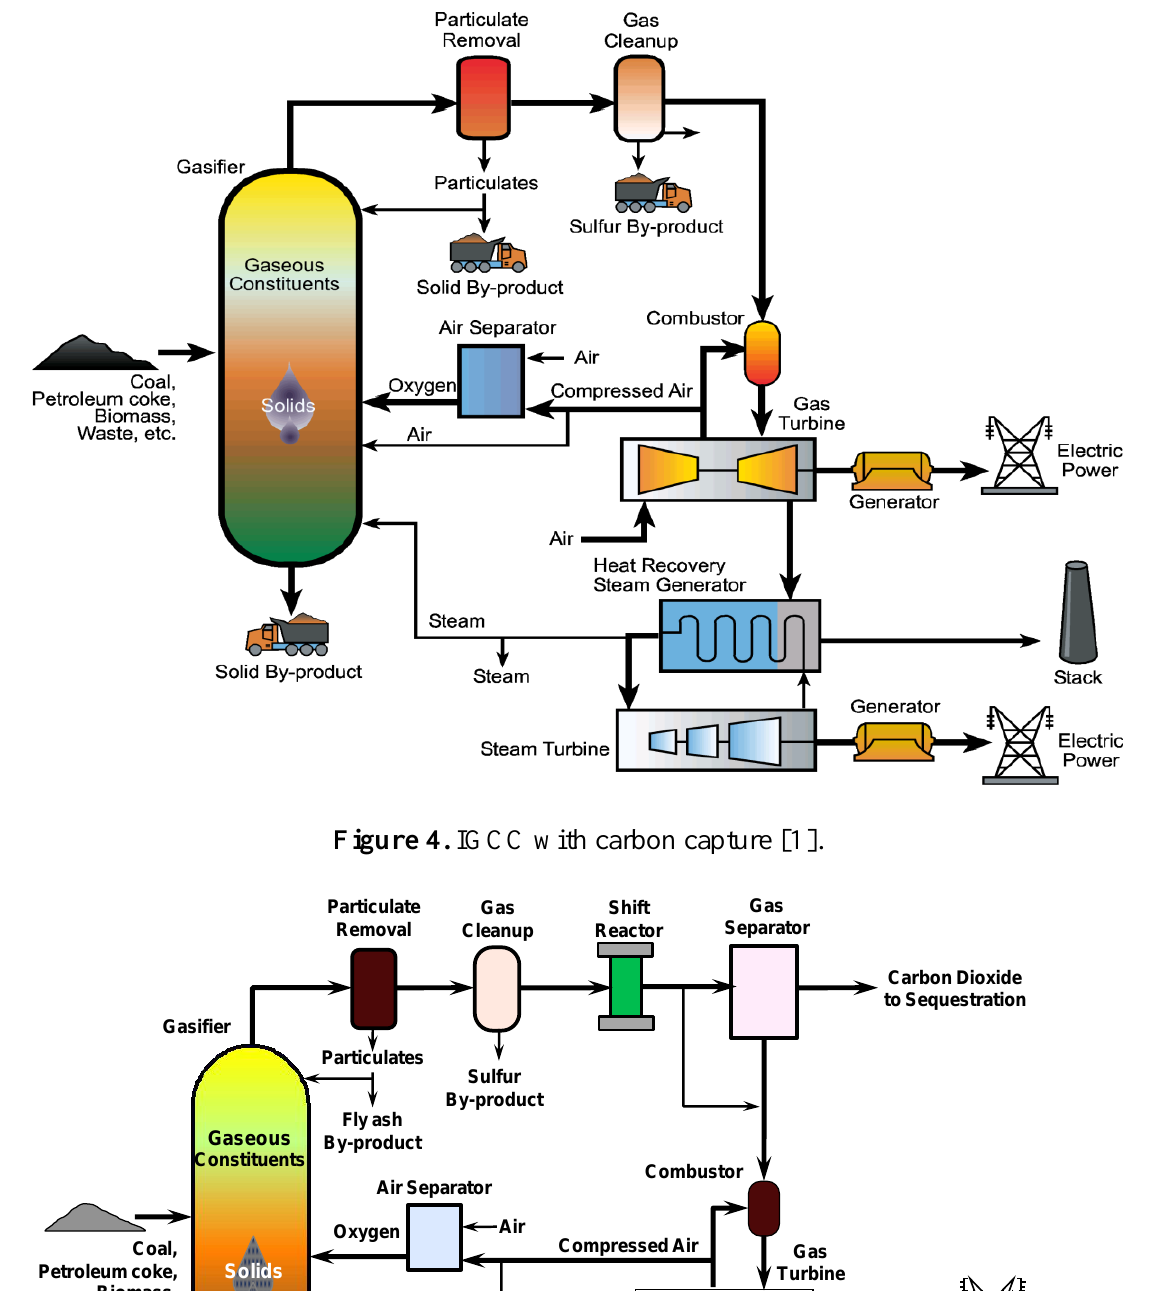
Figure 3. IGCC system without carbon capture [1].